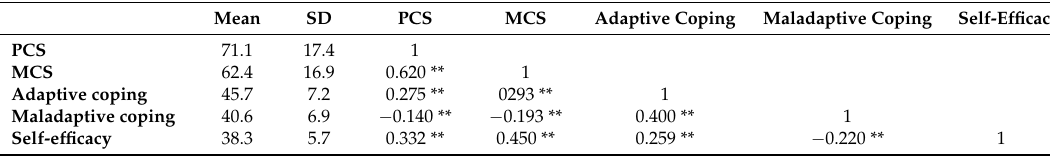
Table 3. Correlation of PCS and MCS and related factors.